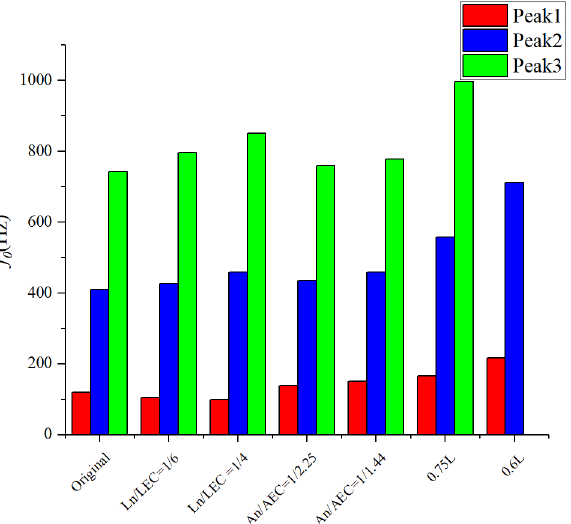
Figure 11. Variation of the resonance frequency of the ITEC with different geometric parameters.